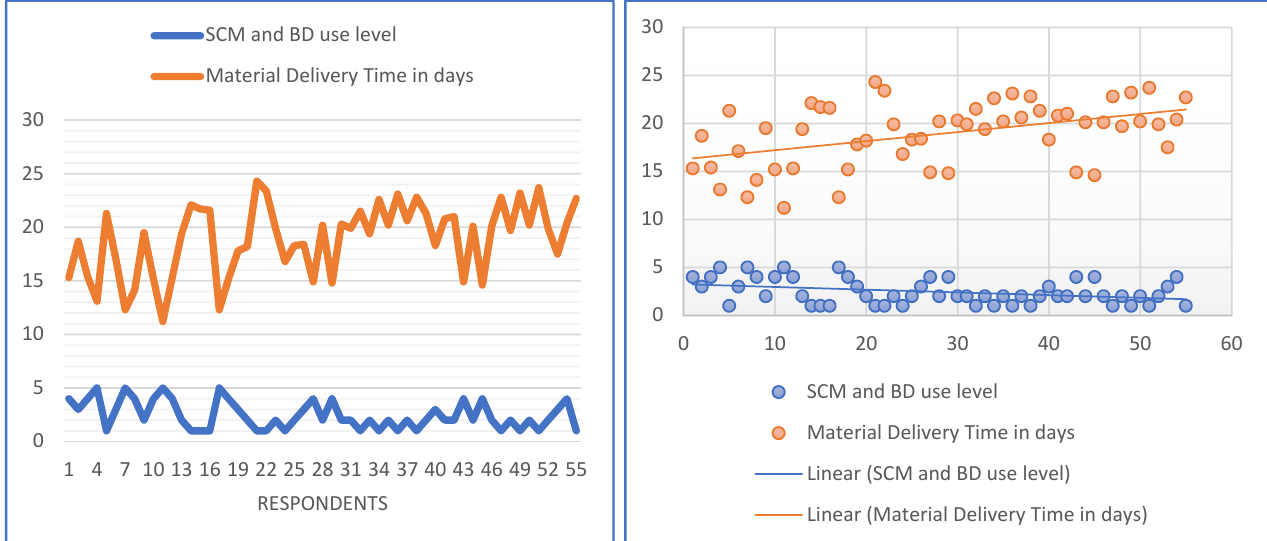
Figure 3. (a) Correlation between the examined variables (level of SCM and BD usage for material delivery time in days and (b) linear correlation between variables Table 2. Pearson correlation (SCM and BD use level and material delivery time in days). SCM and BD Use Level = x Material Delivery Time in Days = y SCM and BD use level = x 1 Material Delivery Time in days = y − 0.921711092